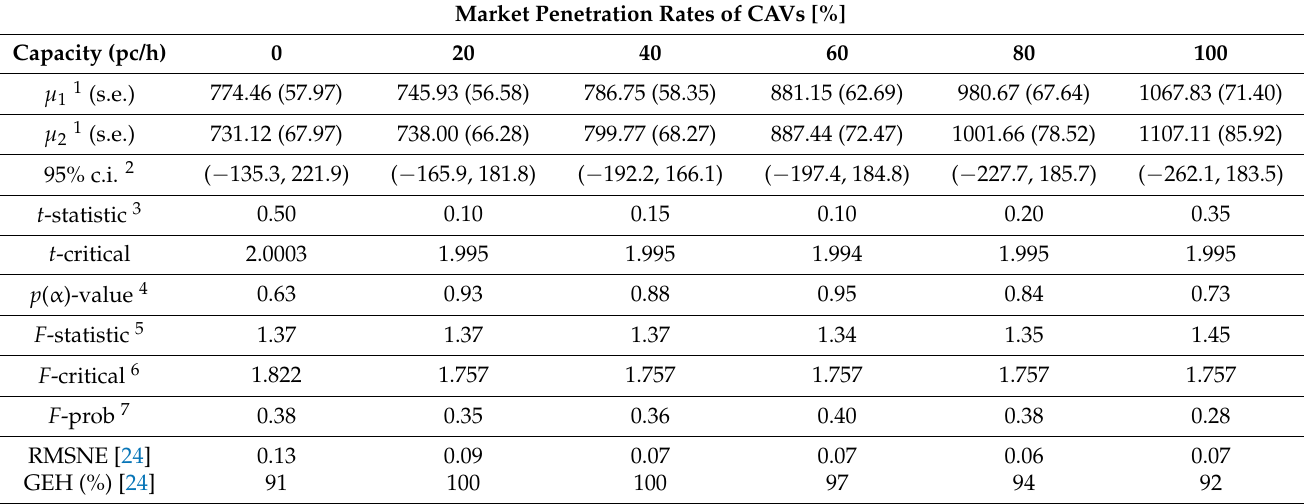
Table 3. Summary statistics for the CAV-adjusted and simulated capacity values for different penetra- tion rates of CAVs on the two-lane